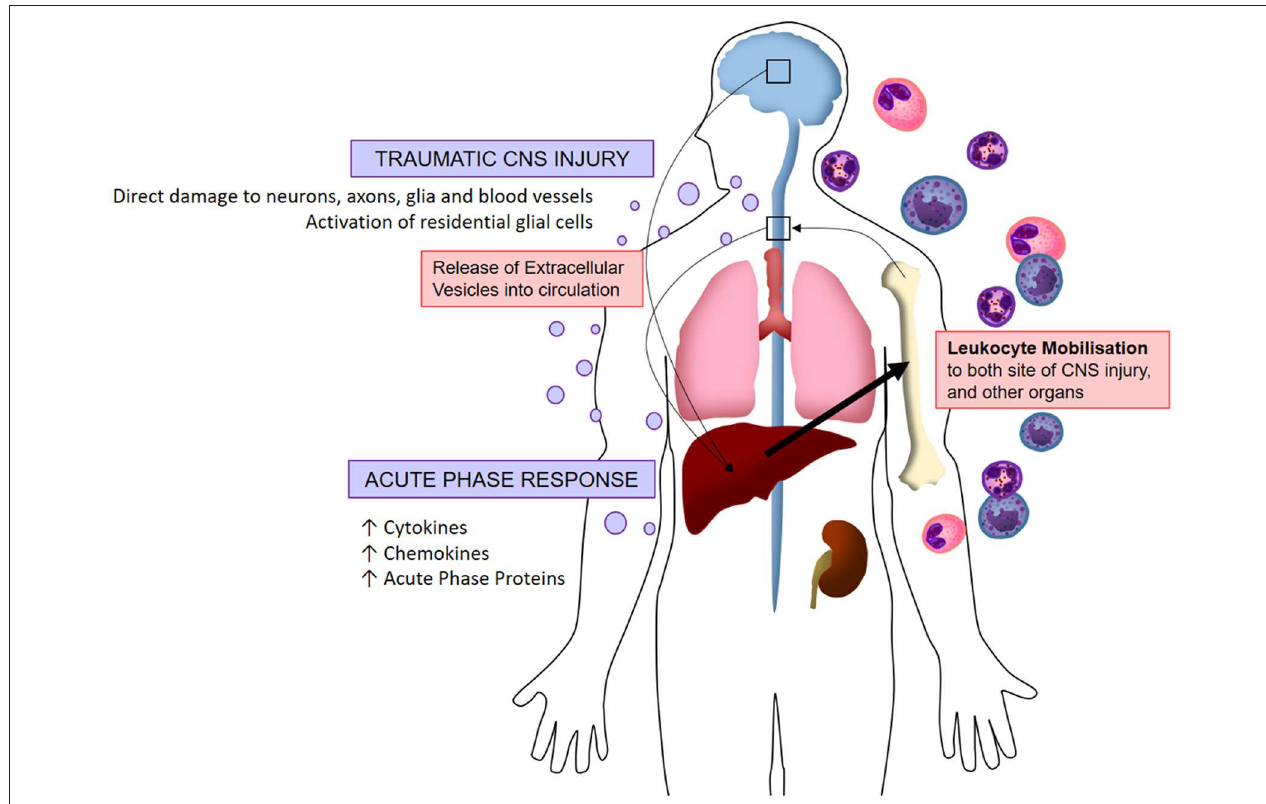
FIGURE 2 | Visualized hypothesis of EV-mediated systemic inflammation response to traumatic CNS injury. Acute traumatic injuries to the brain and spinal cord induce the release of extracellular vesicles into circulation. These EVs localize to peripheral organs whereby they induce the production of pro-inflammatory molecules (chemokines, cytokines, acute phase proteins), in turn stimulating the mobilization of leukocytes which infiltrate both the CNS and peripheral organs. This systemic immune response is referred to as the acute phase response.